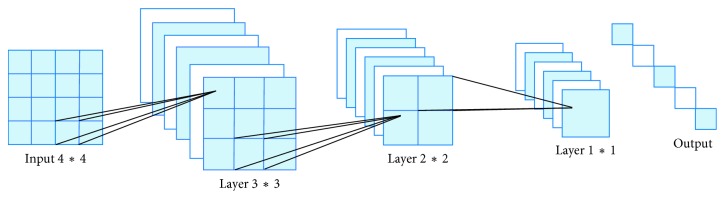
Our CNN structure.